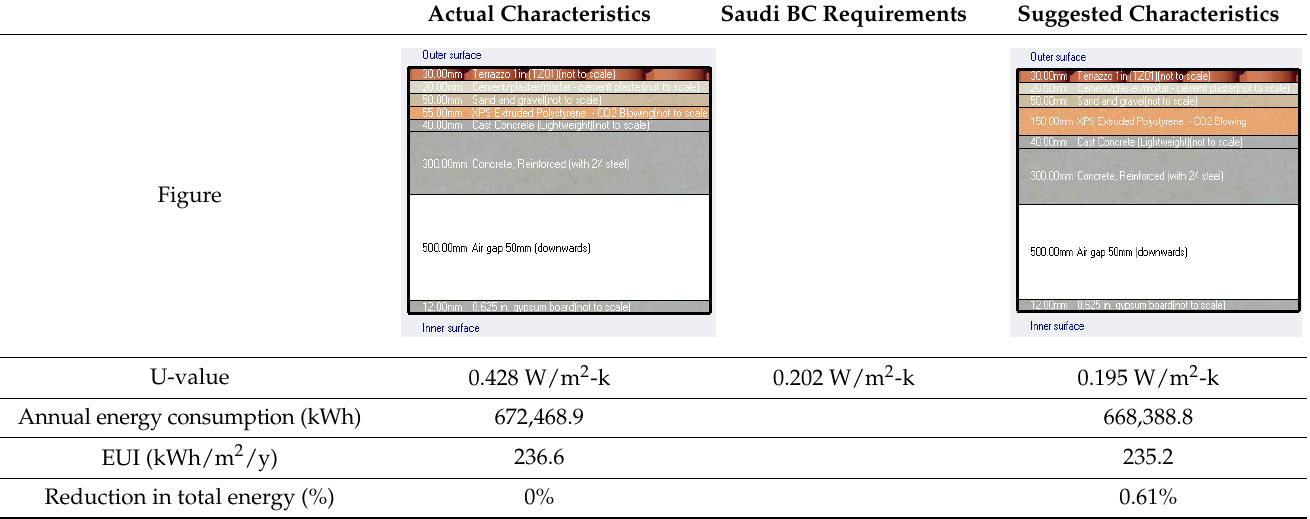
Table 5. The difference in roof lyres between the actual materials and the suggested materials. Actual Characteristics